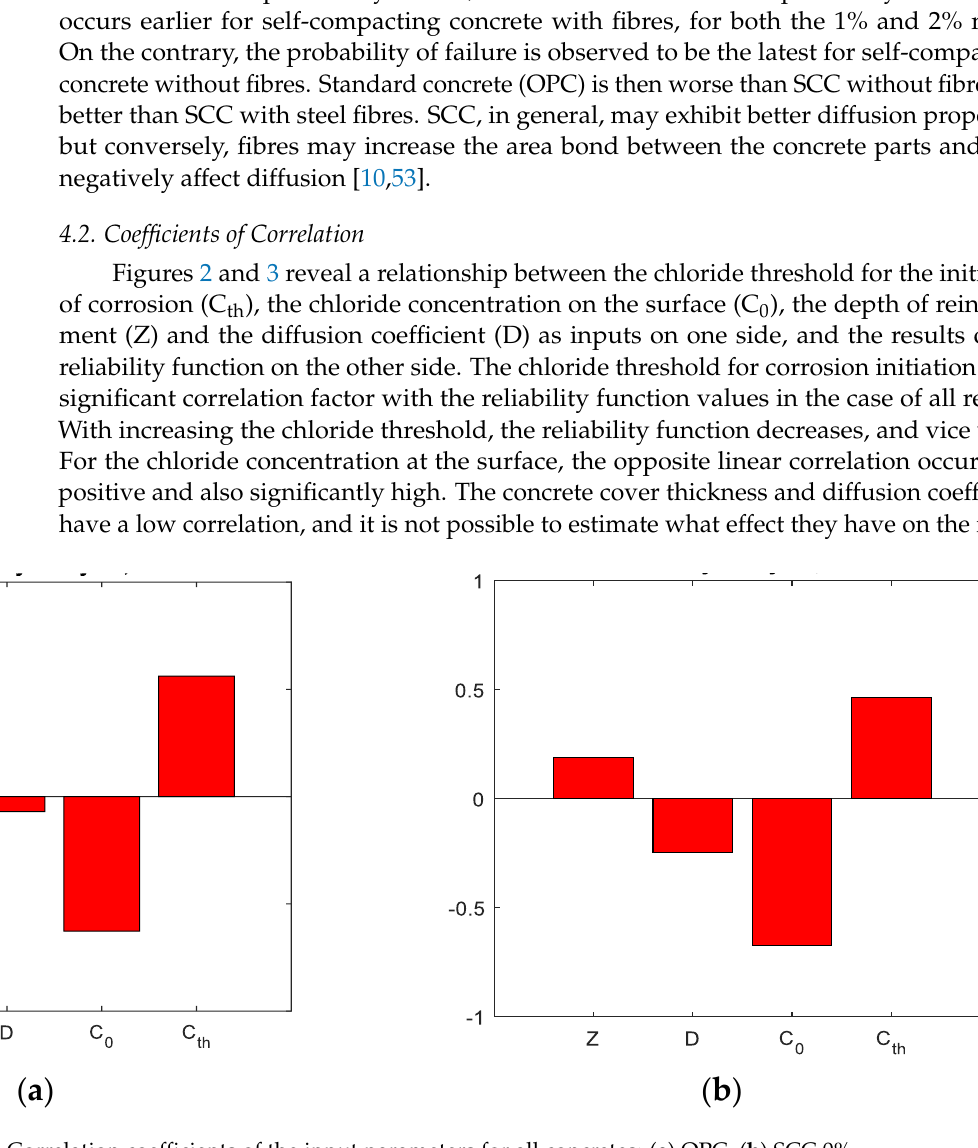
Table 4. Period to the initiation of corrosion, t i (years), for a selected probability of the initiation of corrosion. Mixture No.